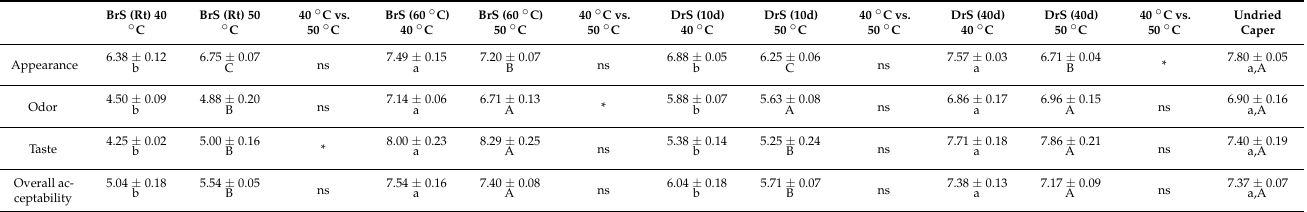
Table 3. Sensory acceptability of caper powder samples obtained from the different